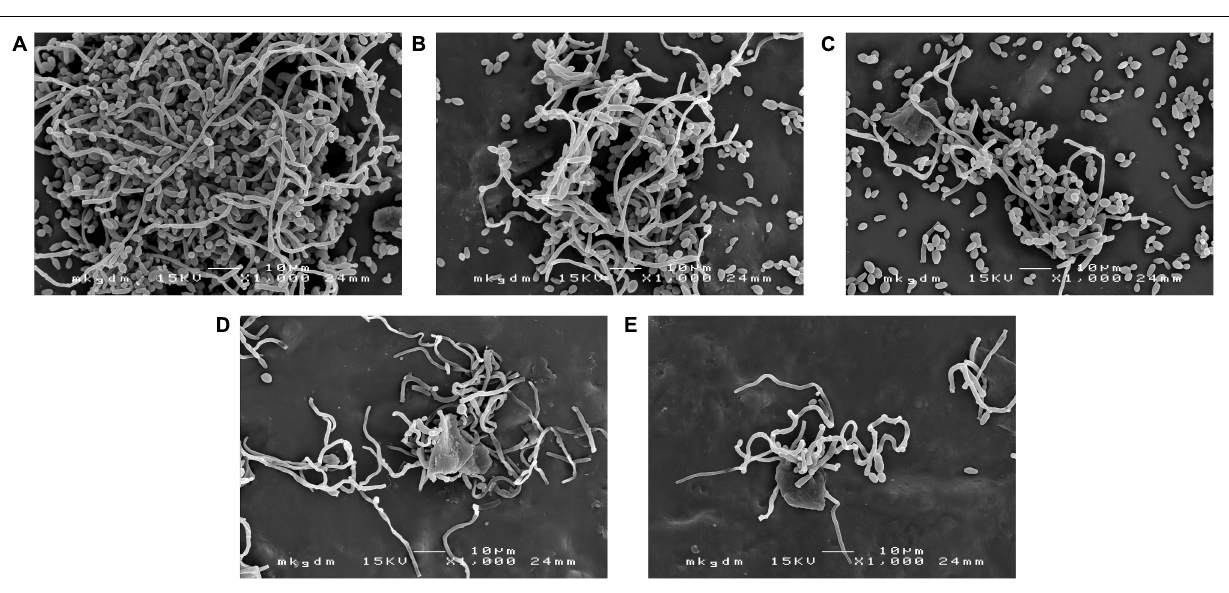
FIGURE 7 | SEM images of the biofilm by C. albicans DAY 185 on untreated (A) or free AMB (B) , CSNPs-AMB (C) , AMB+Gls (D) , and CSNPs-AMB-Gls (E) treated silicone